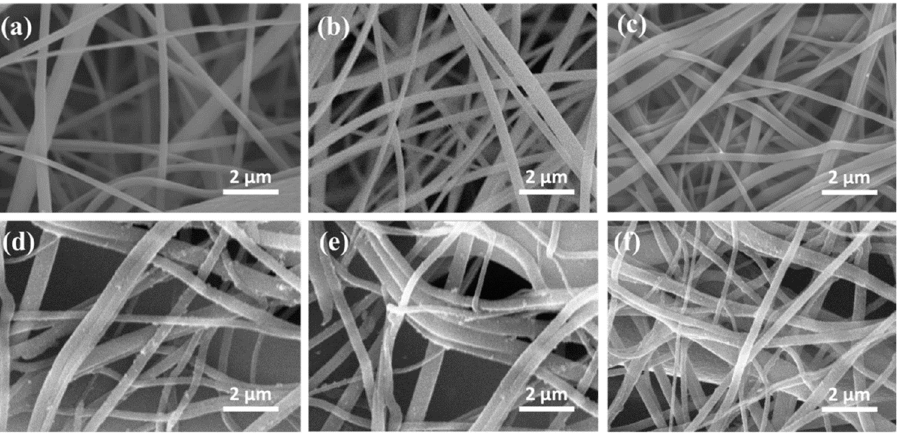
Figure 10. SEM analysis for: ( a ) cellulose acetate, ( b ) cellulose nanofibers, ( c ) orange-oil cellulose nanofibers, ( d ) Ag-cellulose nanofibers, ( e ) Ag-orange oil 5% cellulose nanofibers, ( f ) Ag-orange oil 10% cellulose nanofibers. Reprinted from an open source article [137].